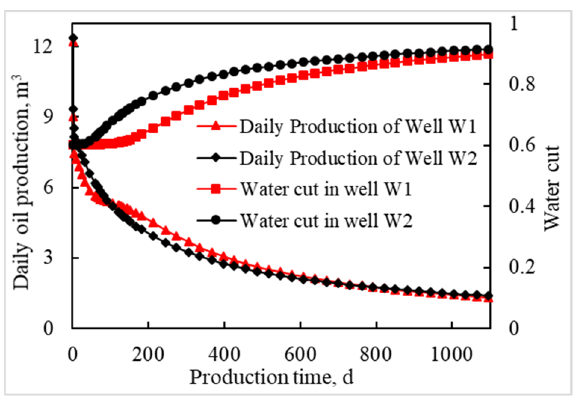
Figure 10. Production situation under different fracture orientation conditions.